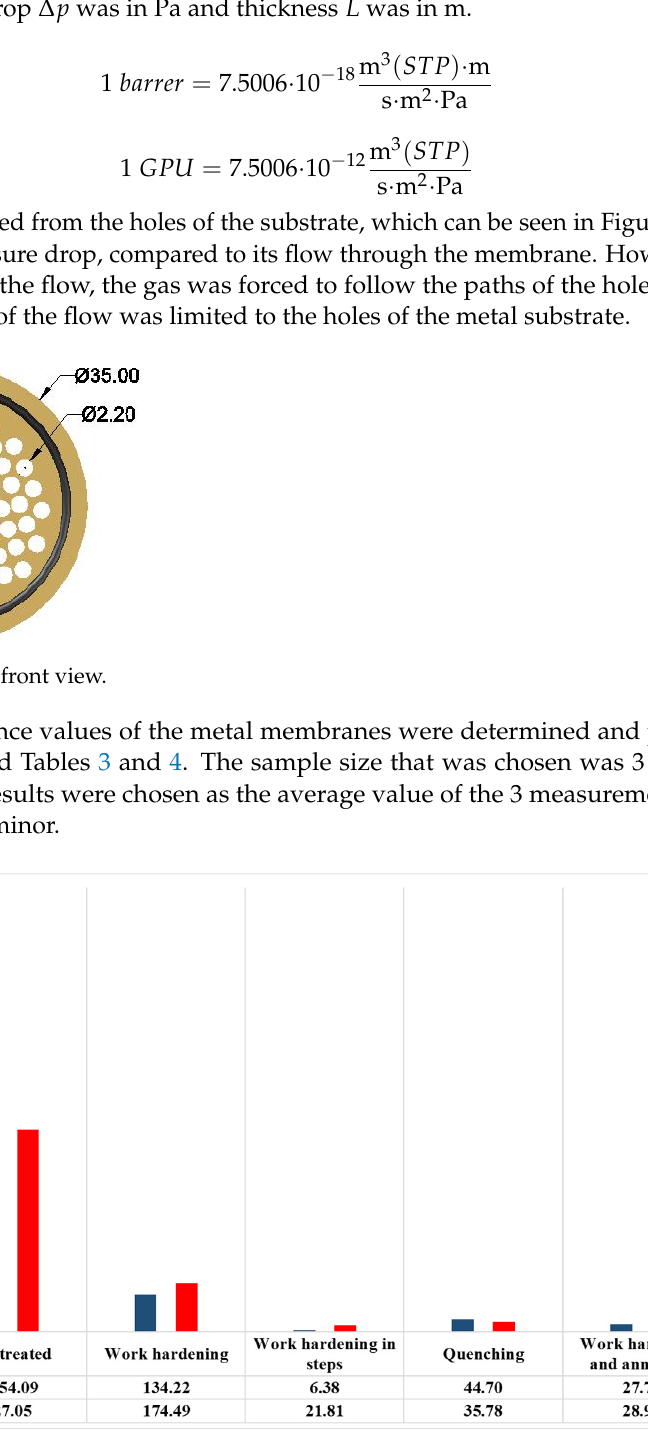
Figure 10. Permeance values (in GPU units) of metal membranes.